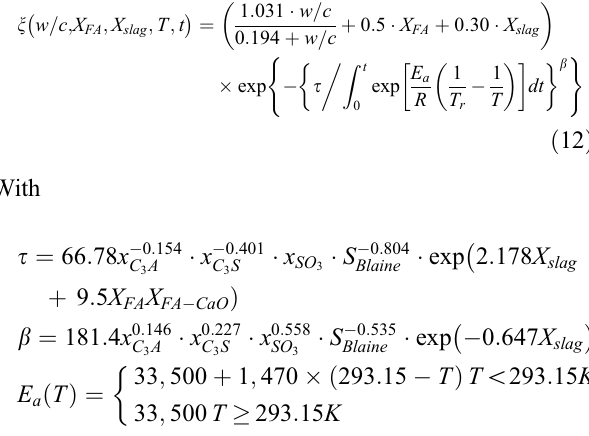
ffiffiffiffiffiffiffiffiffiffiffiffiffiffiffiffiffiffiffiffiffiffiffiffiffiffiffiffiffiffiffi B 2 þ B 2 4